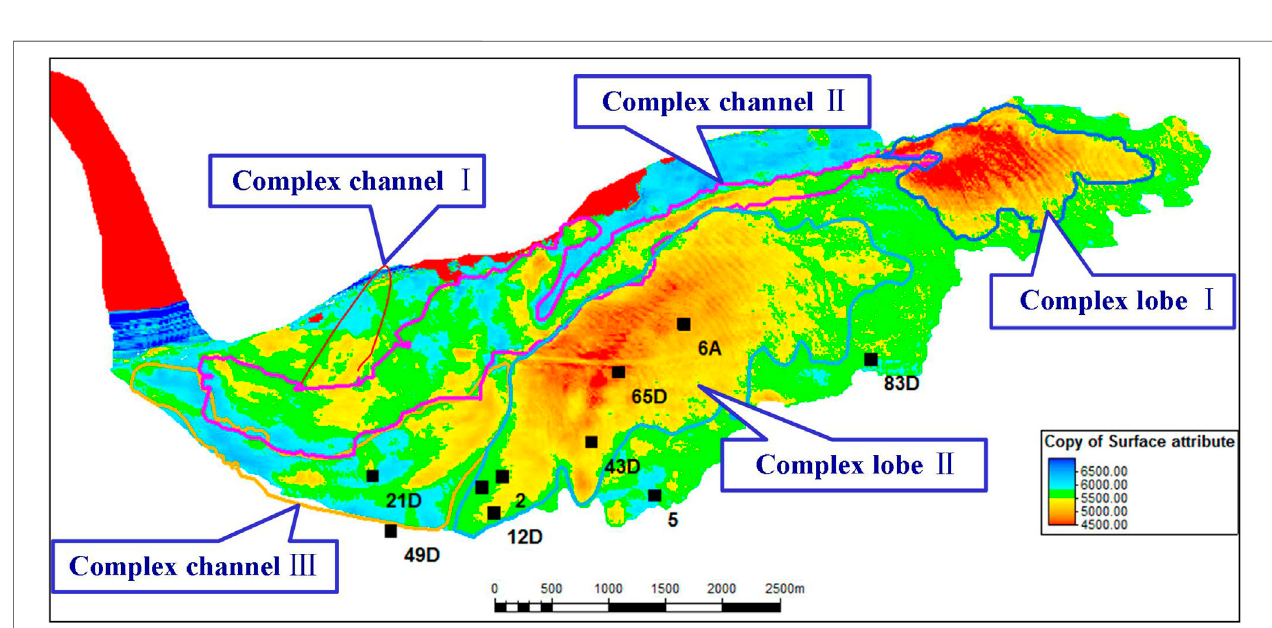
FIGURE 17 | AB120 reservoir plane attribute map (minimum impedance